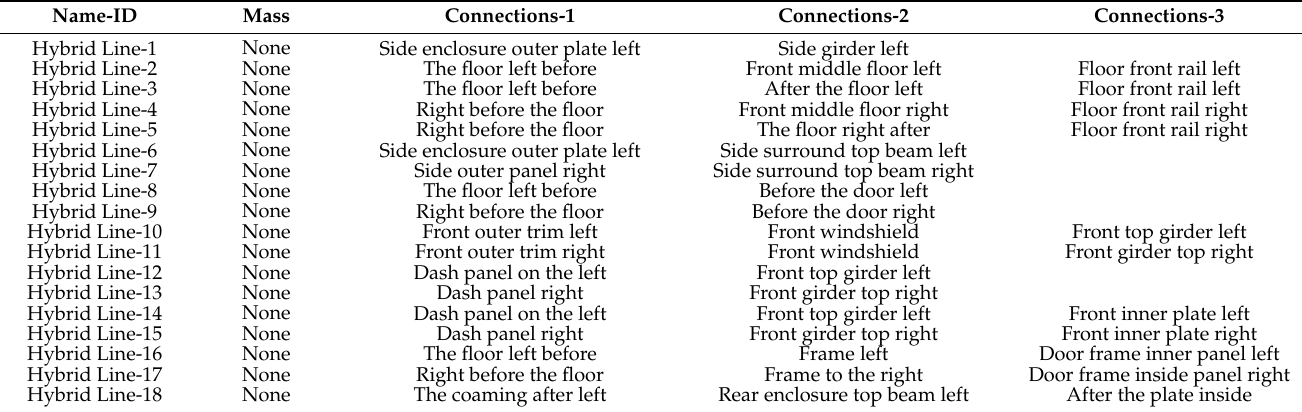
Table 3. Part of the hybrid wire connection